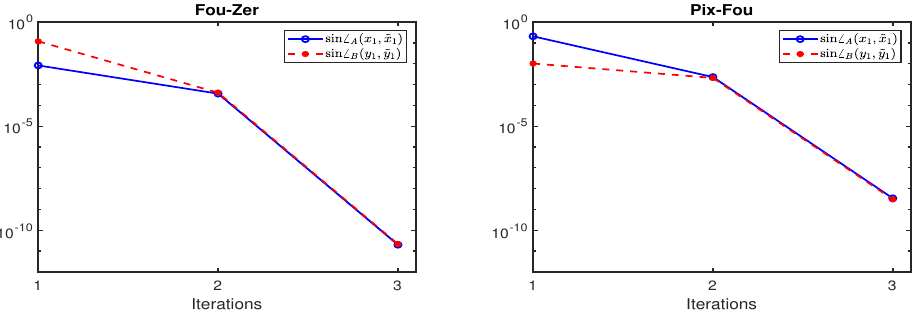
Figure 1. Convergence behavior of Algorithm 1 for computing the first canonical weight vector of Fou-Zer and